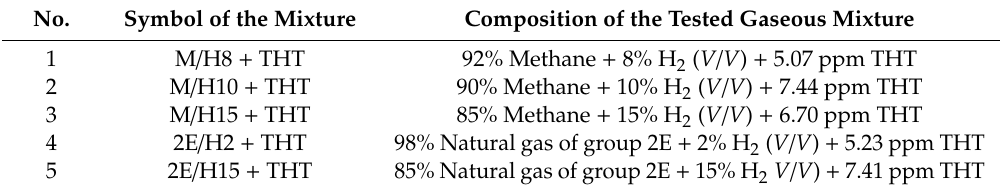
Table 2. List of the compositions of tested gaseous